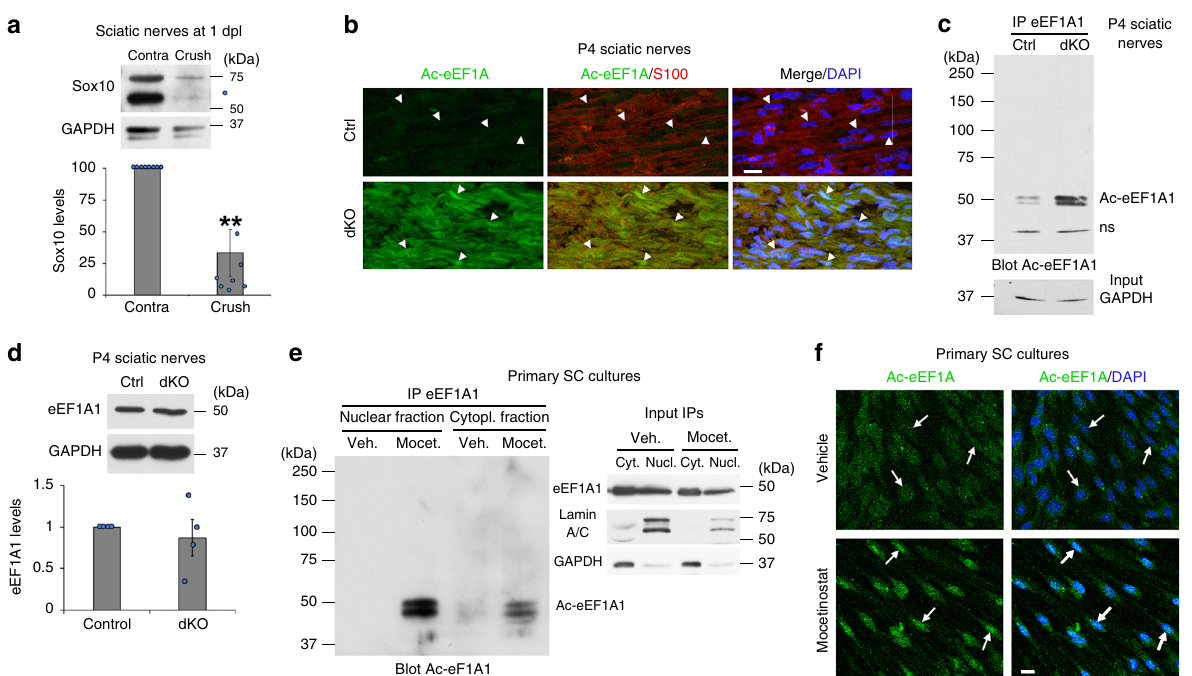
Fig. 1 EEF1A1 is deacetylated by HDAC1/2 in SCs. a Sox10 Western blot and quanti fi cation normalized to GAPDH showing low Sox10 levels at 1dpl in crushed as compared to contralateral sciatic nerves of adult mice. Paired two-tailed Student ’ s t -tests, p value = 0.008938, n = 8 animals per group. b , c Co-immuno fl uorescence of Ac-eEF1A and S100 (SC marker) and DAPI (nuclei) labeling ( b ) and immunoprecipitation (IP) of eEF1A1 and Western blot of Ac-eEF1A ( c ) in sciatic nerves of P4 control (Ctrl) and DhhCre;Hdac1;Hdac2 knockout (dKO) mice showing increased levels of Ac-eEF1A in the absence of HDAC1/2 in SCs. n.s. = non-speci fi c. d Western blot of total eEF1A1 and GAPDH (loading control) in sciatic nerves of P4 Ctrl and dKO mice and quanti fi cation of eEF1A1 levels normalized to GAPDH levels showing no signi fi cant difference between the two groups. Paired one-tailed Student ’ s t -tests, p value = 0.297774, n = 4 animals per group. e IP eEF1A1 followed by Western blot of Ac-eEF1A in nuclear and cytoplasmic fractions of primary SCs cultured under de-differentiating conditions and treated with the HDAC1/2 inhibitor mocetinostat (Mocet.) or its vehicle (Veh.) for 3 days. Lamin A/C (nuclear marker), GAPDH (cytoplasmic marker) and eEF1A1 Western blots on lysates used for IP show the inputs. f Immuno fl uorescence of Ac-eEF1A and DAPI labeling in primary SCs cultured under de-differentiation conditions and treated with mocetinostat or its vehicle for 3 days. Arrowheads ( b ) and arrows ( f ) show SC nuclei. Z-series projections ( b ) or single optical sections ( f ) are shown. b , f Representative images of 3 different animals per group or of 3 independent experiments are shown. b , d Data are presented as mean values ± SEM. Scale bars: 10 µ m. Source data are provided as a Source Data fi